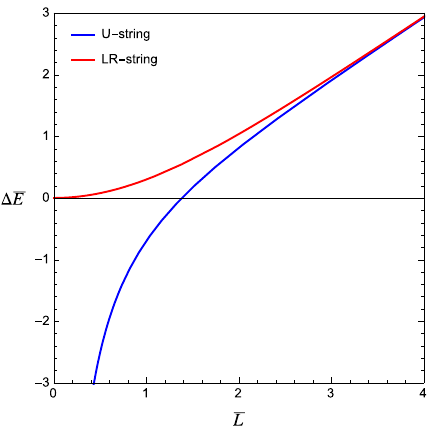
Figure 6 . The energy (cid:1) (cid:22) E of a quark-antiquark pair as a function of its separation (cid:22) L . Con(cid:12)gu- rations within the same boundary, dual to U-shaped strings, are plotted in blue, and Left-Right con(cid:12)gurations, dual to strings which traverse the throat, are plotted in red. where d (cid:6) 2 now corresponds to a 3-dimensional space of negative constant curvature, locally 3 equivalent to (cid:6) = S 1 (cid:2) H , (cid:26) 2 R , and where (cid:26) is an arbitrary constant that 3 2 0